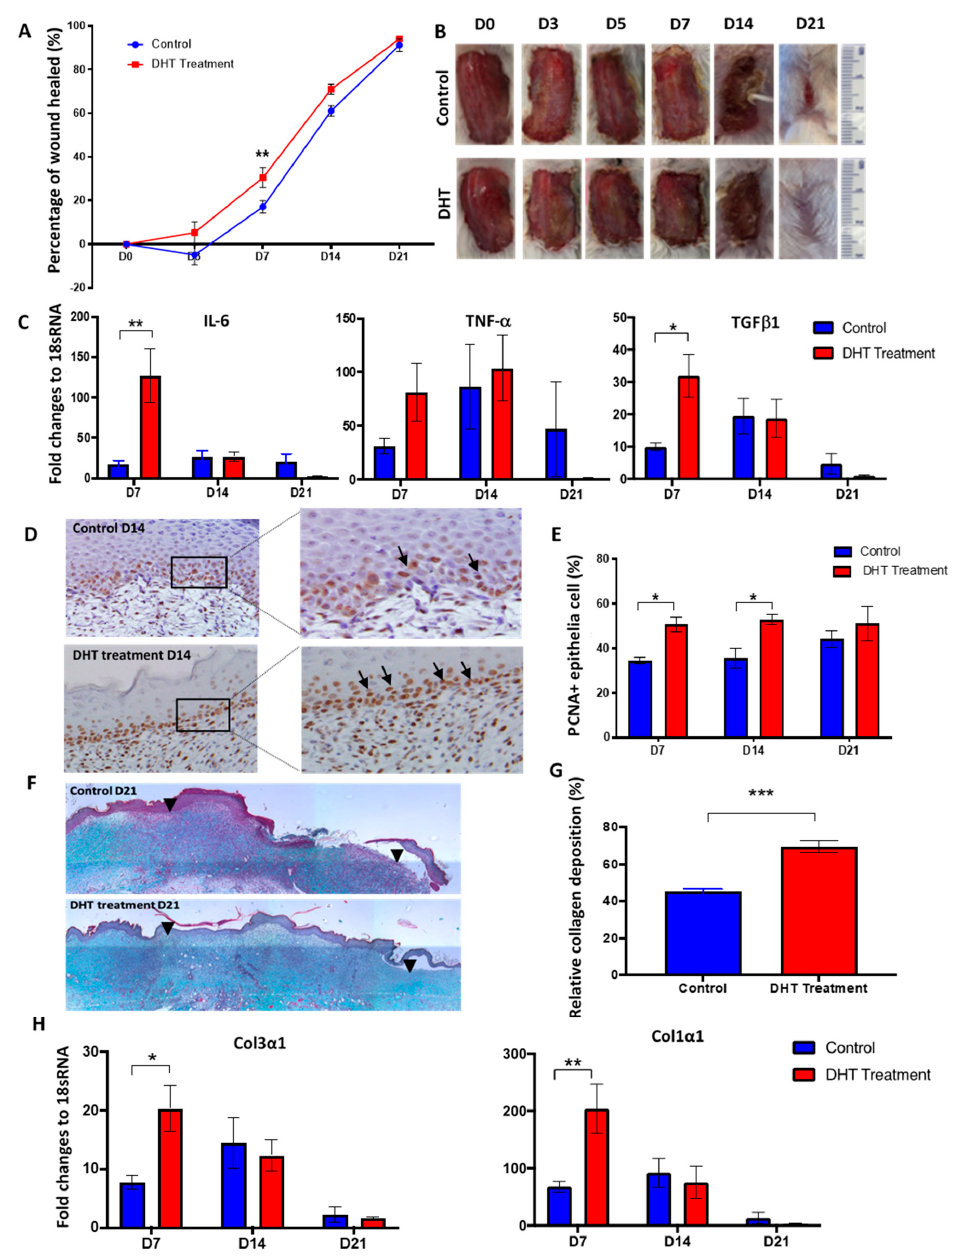
Figure 1. Major burn wound healing is accelerated in dihydrotestosterone (DHT)-treated mice. ( A ) Wound healing rates were quantified as the percentage of the wound healed. ( B ) Progression of burn wound healing, with healing completed by day 21 in DHT-treated mice. ( C ) Fold changes relative to housekeeping gene 18sRNA for IL-6, TNF α , TGF β mRNA expression in the wound in control and DHT treatment. ( D ) Represented images showing more proliferating cell nuclear antigen (PCNA) staining in DHT-treated mice on day 14. ( E ) Quantification of positive PCNA + epithelia cells per 30 cells by PCNA staining, illustrating a significant increase of proliferating epithelia cells in DHT- treated mice at D7 and day 14. ( F ) Masson trichrome staining showing more collagen deposition in the wound of DHT treatment group. Black arrowheads indicate edges of the wound. ( G )